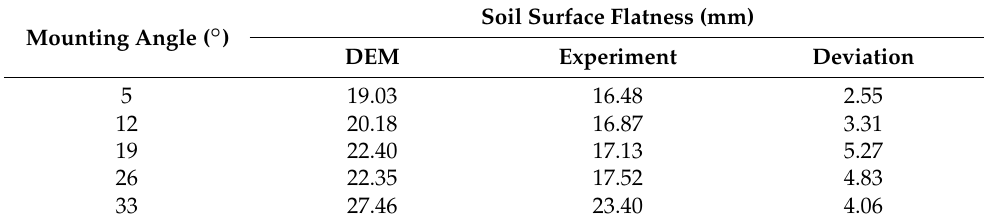
Table 2. Soil surface flatness as affected by mounting angle.